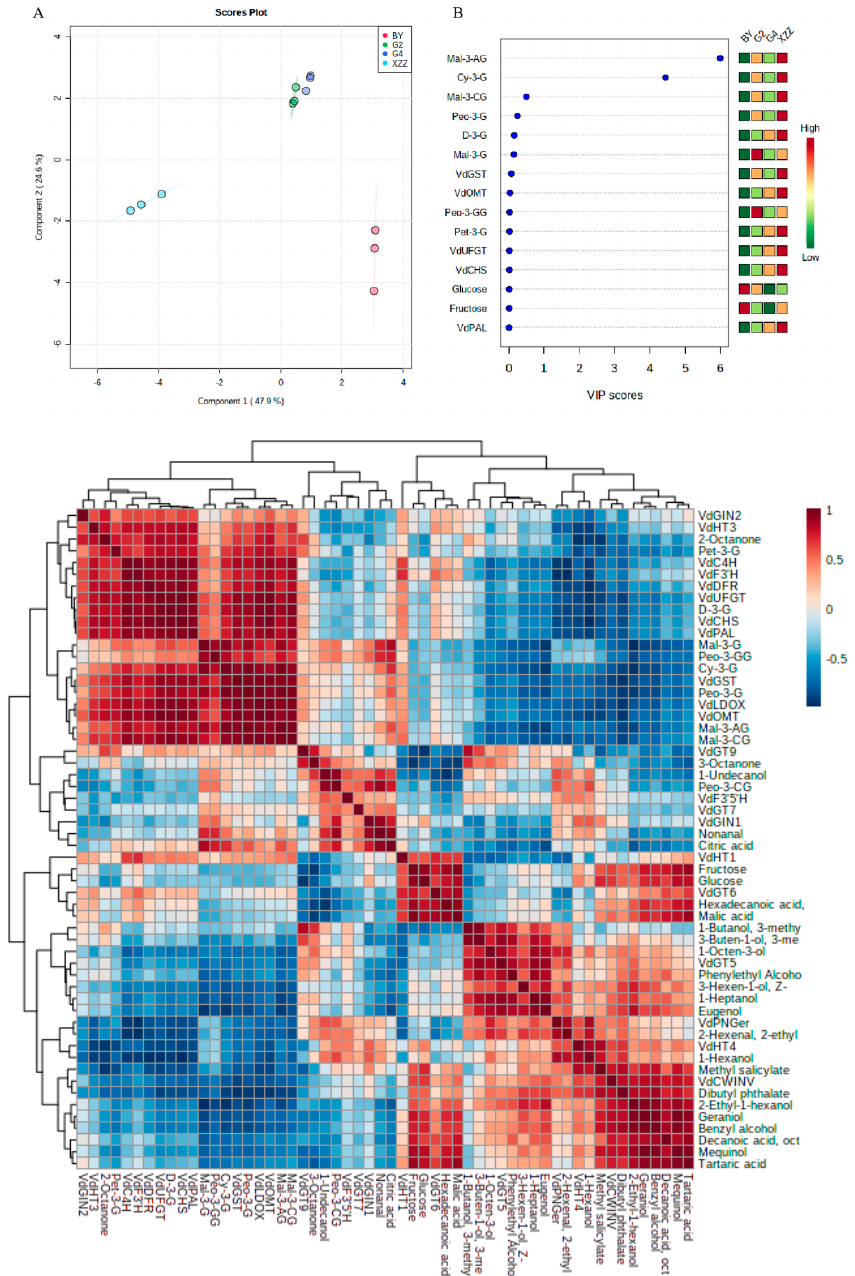
Figure 4. Multivariate statistical analysis. ( A ) Score plot of partial least-square discriminant analysis (PLS-DA) using metabolites and gene expression levels researched in this study. The PLS regression is performed using the plsr function provided by R pls package. The classification and cross-validation are performed using the corresponding wrapper function o ff ered by the caret package provided by MetaboAnalyst. To assess the significance of class discrimination, a permutation test was performed. In each permutation, a PLS-DA model was built between the data ( X ) and the permuted class labels ( Y